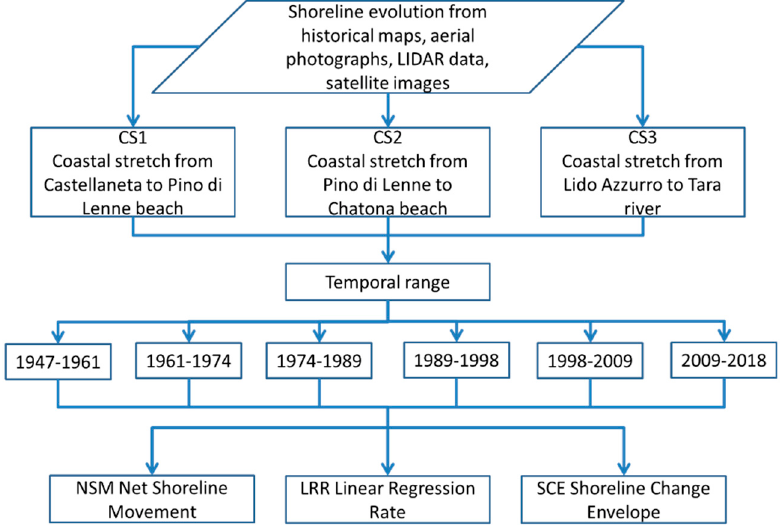
Figure 8. Flow chart of shoreline change analysis performed over different time spans using Digital Shoreline Analysis System (DSAS).